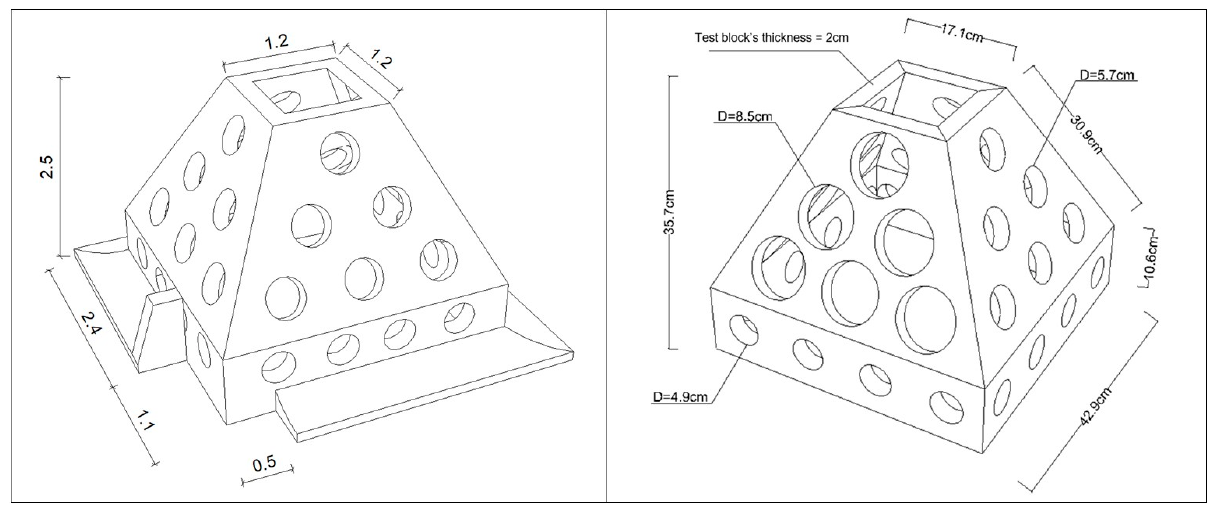
Figure 5. Size of the prototype PTPBW block and physical modelling.